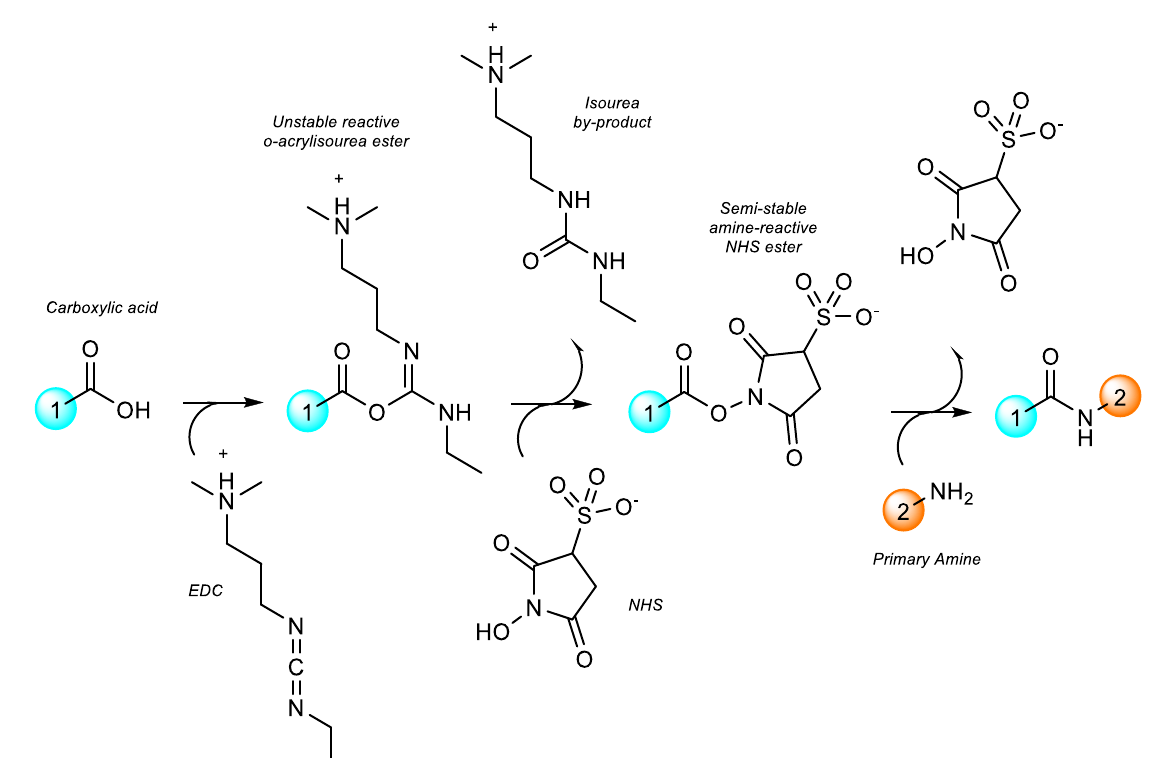
Figure 19. General reaction mechanism of the conjugation of a carboxylic acid-containing substrate with a primary amine functional group via covalent immobilization using N -ethyl- N ’-(3-dimethyl aminopropyl)carbodiimide (EDC) and N -hydroxysuccinimide (NHS).